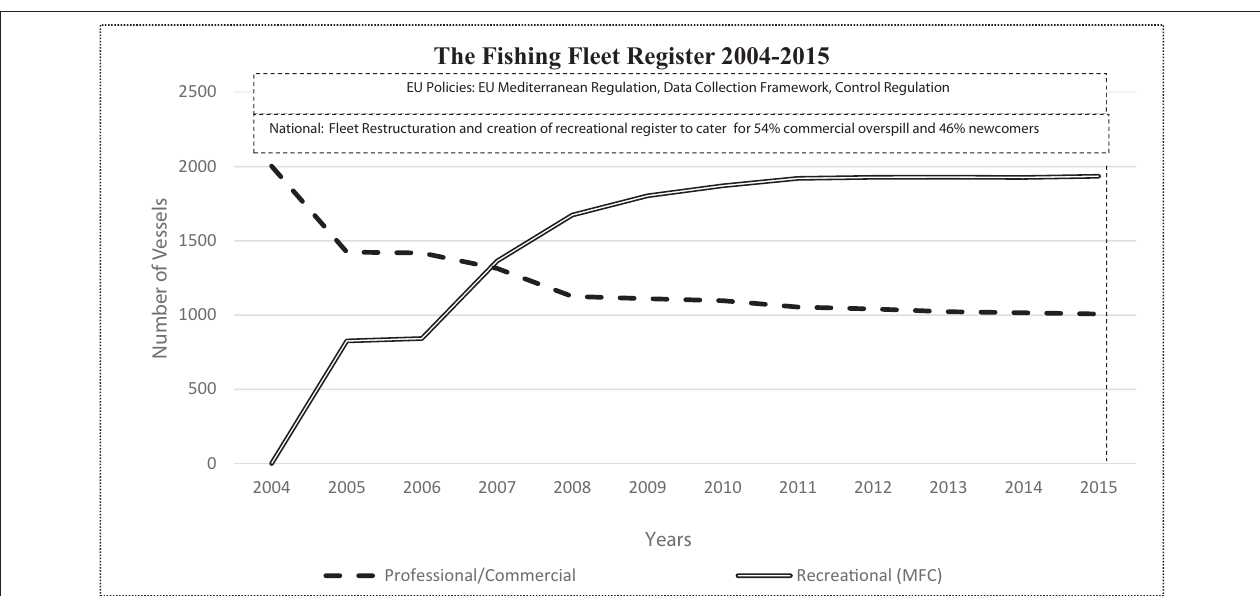
FIGURE 1 | This chart, which is based on data supplied by the National Statistics Office and the Department of Fisheries and Aquaculture, illustrates the way by which the national fishing fleet register has evolved in tandem with policy shifts in the past decade since EU accession. It demonstrates how the commercial segments have decreased drastically through the restructuration phase in 2005 which saw the establishment of a recreational sector that has initially acted as an overspill register of the commercial fleet, and has since then grown to become the biggest fleet